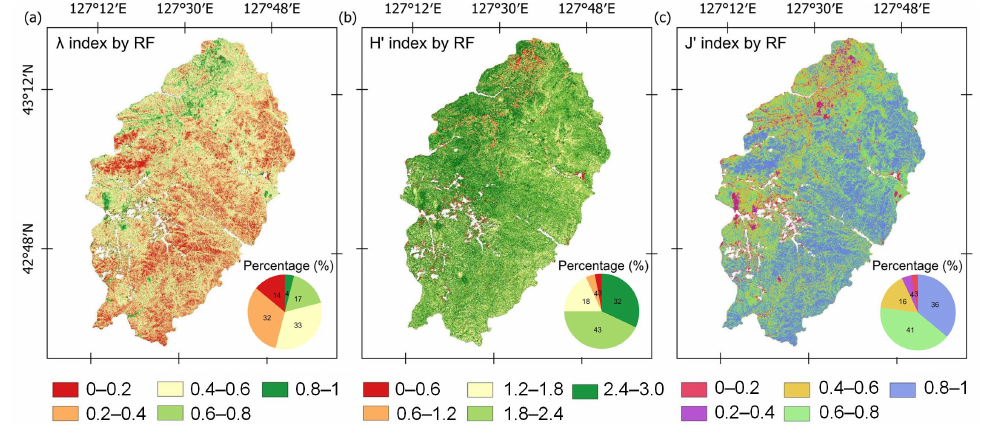
Figure 4. Predicted maps and pixel statistics of forest diversity by the three indices ( a ) λ index, ( b ) H ′ index, ( c ) J ′ index using the RF model.